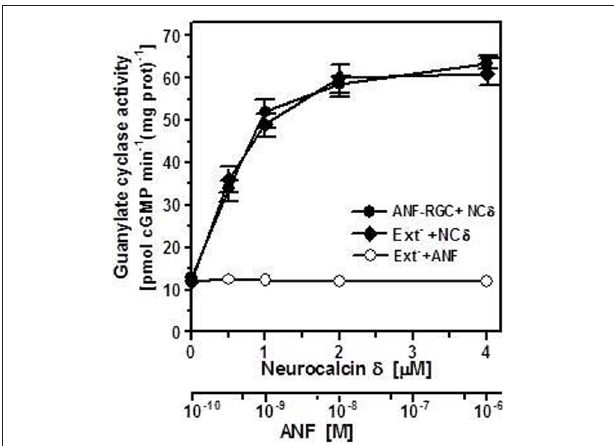
fashion ( Figure 2 : closed diamonds). The stimulatory profile was indistinguishable from that of the full-length ANF-RGC ( Figure 2 : closed circles). Also the Hill’s coefficients for the neu- rocalcin δ effect on both cyclases were identical 2.1 ± 0.5 and 2.05 ± 0.4 for the full-length ANF-RGC and for the deletion mutant, respectively. It is, therefore, concluded that the extra- cellular domain has no structural role in ANF-RGC ability to respond to and be stimulated by myristoylated neurocalcin δ .